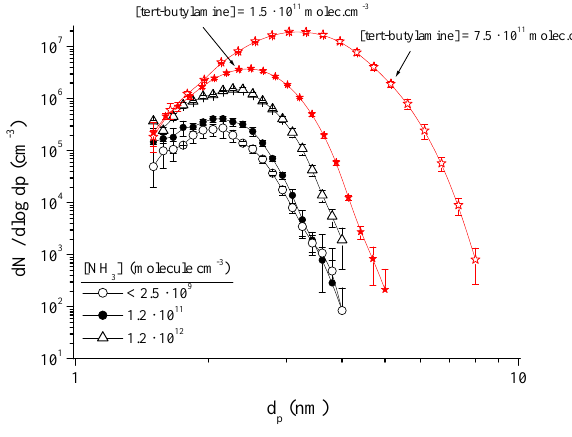
Fig. 11a. Particle size distributions obtained in absence or presence (1.2 × 10 11 or 1.2 × 10 12 moleculecm − 3 ) of NH 3 additions or tert- butylamine (1.0 × 10 11 moleculecm − 3 ); total gas flow: 30lmin − 1 STP. Relative humidity: 13%; [H 2 SO 4 ]=8 × 10 8 moleculecm − 3 .